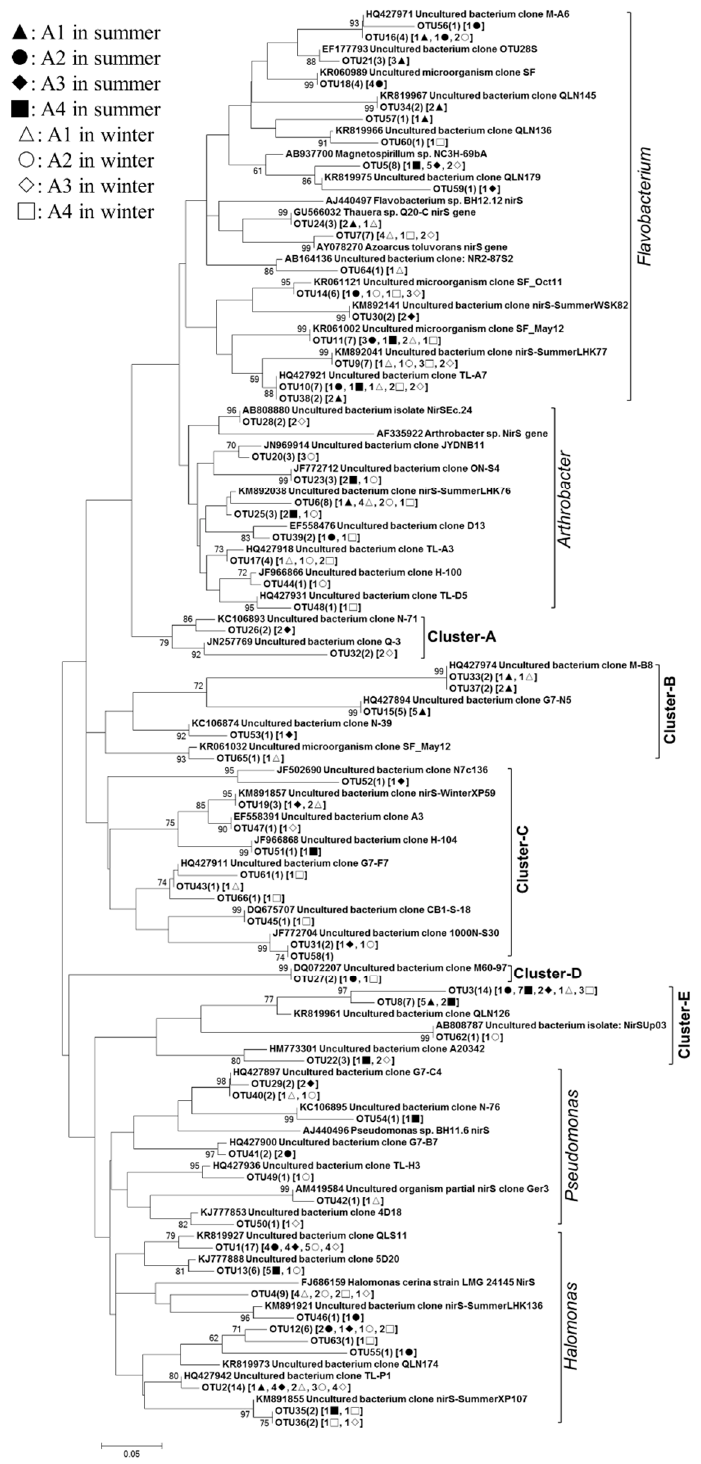
Figure 7. Neighbor-joining phylogenetic tree based on the nucleotide sequences of the nirS gene. The numbers at the nodes represented the credible values that were calculated from 1000-times bootstrap tests. Bootstrap values greater than 50% were shown. The scale bar indicated 0.05 substitutions per nucleotide position. GenBank accession numbers were shown for sequences from other studies. Numbers in parentheses following each OTU indicated the number of sequences recovered from each sampling site.